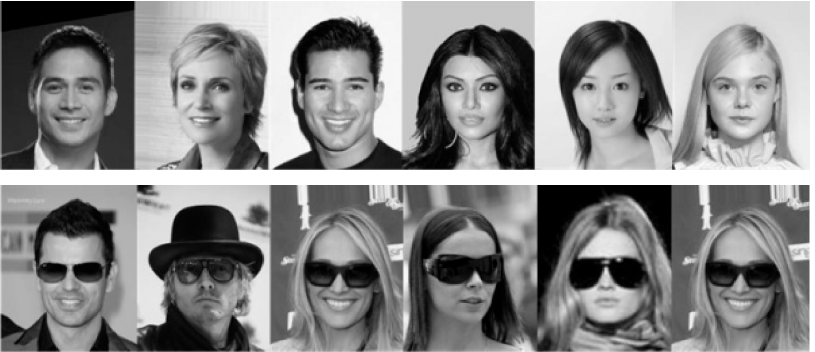
Figure 5. Some examples of CelebA: the first line represents positive samples, and the second represents negative samples.